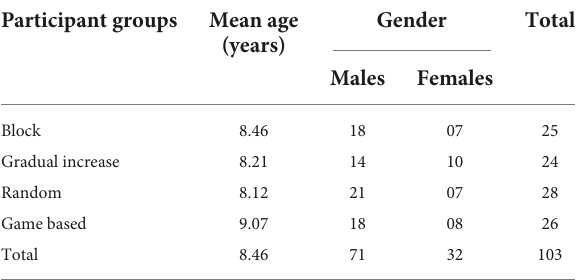
TABLE 2 Distribution of participants by gender and practice group ( N =